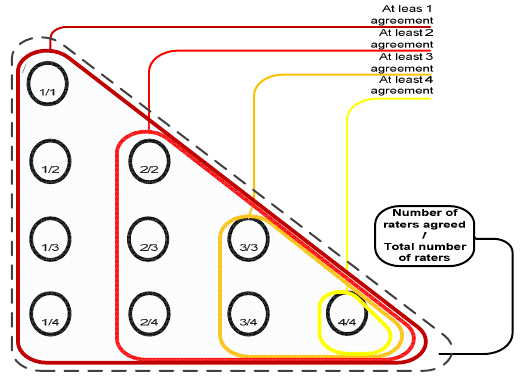
Figure 5. Reference truths for the LIDC